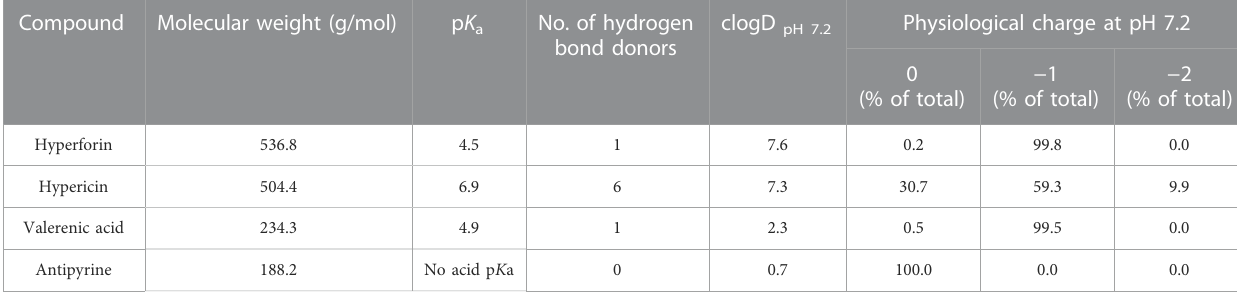
TABLE 2 Predicted physicochemical properties of study compounds.